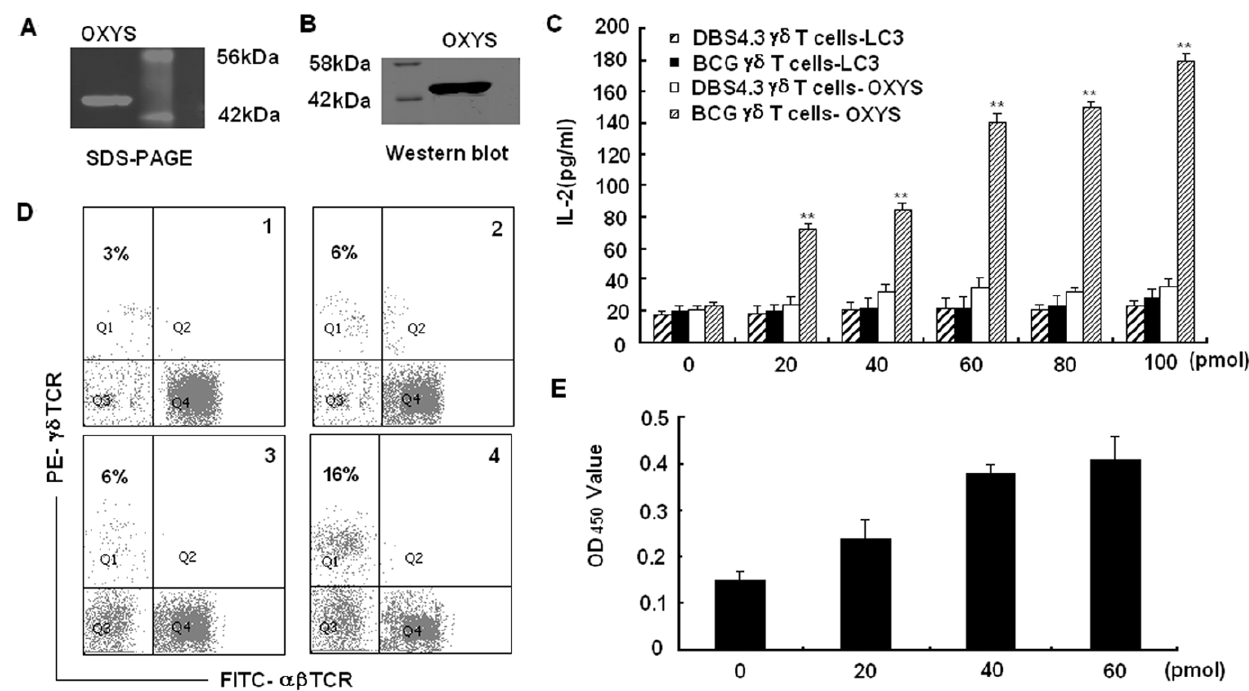
Figure 6. Binding and activating cd T cells by OXYS protein invitro . (A) The expression of OXYS protein in E. coli was confirmed by 12% SDS- PAGE. The molecular weight of the expressed OXYS is 44KD (B) The expression of OXYS protein was further confirmed by western blot using anti his- tag antibody. (C) OXYS protein could stimulate the BCG cd T cells to produce IL-2 in a dose-dependent manner. LC3 protein, an autophagy detection marker was used as the control protein. Data are shown as the mean of pg/ml 6 S.D. of three independent experiments. The double asterisks represent significance difference (P , 0.01). (D) OXYS protein could induce the expansion of cd T cells from human subjects inoculated with BCG. Results are representative of three independent experiments. Panel 1 and panel 2 was the expansion percentage of cd T cells from human subjects un-inoculated with BCG and inoculated with BCG induced by control protein, respectively. Panel 3 and panel 4 was the expansion percentage of cd T cells from human subjects un-inoculated with BCG and inoculated with BCG induced by OXYS, respectively. (E) Detection of cd T cell proliferation by CCK-8 assay. After the cd T cells expanded by protein were isolated by flow sorting, they (1 6 10 5 /100 m l) were inoculated into a 96-well plate immobilized with different dosage of protein and incubated for 4 hours. CCK-8 reagent (10 m l) was added to each pore and continued to culture for 4 hours until the media turned yellow. The absorbance value (450 nm) of each pore was measured using a microplate reader. Data are shown as the mean of three independent